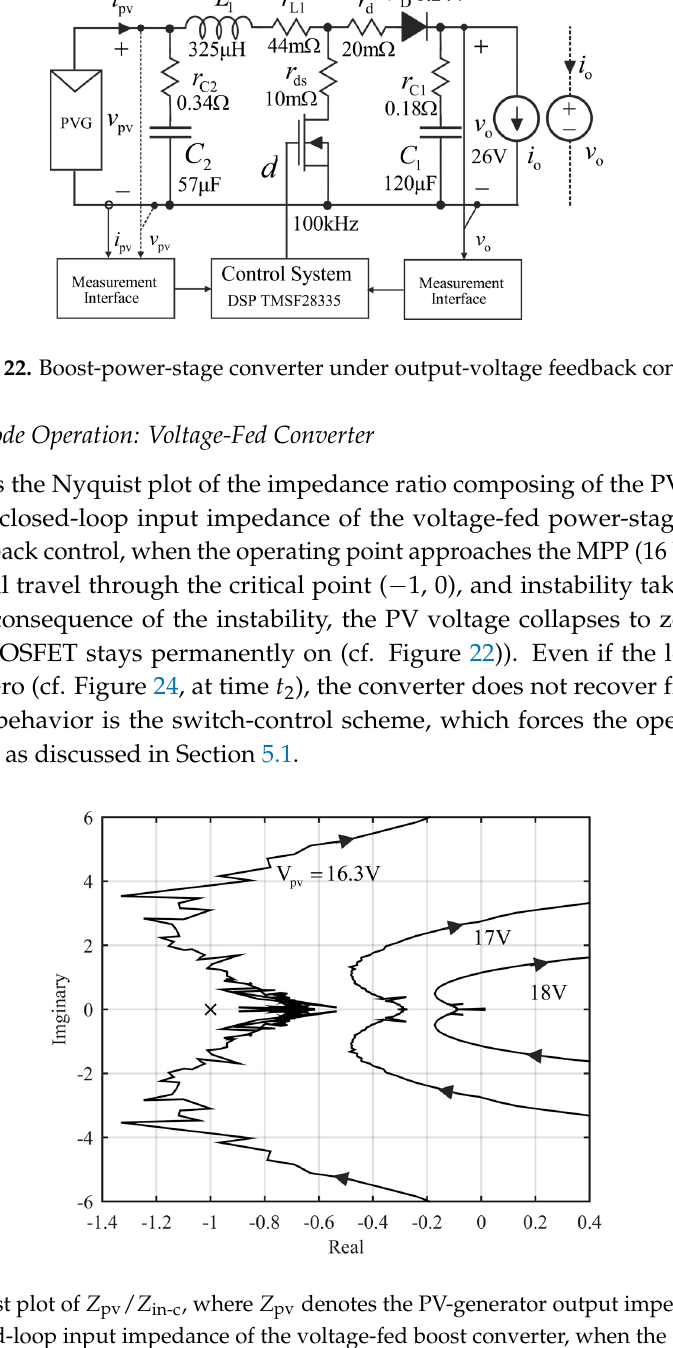
Figure 24. Behavior of boost-converter output voltage ( out v ) and current ( out i ) as well as PV-generator voltage ( pv v ), when the operating point reaches the MPP due to a step change in the output current of the boost converter (i.e., at time 1 t ). It may be obvious that the stable operational region of the output-voltage-feedback-controlled voltage-fed power-stage converter will be always in CVR starting from the open-circuit condition to the highest MPP voltage. In the case of multiple MPPs (cf. Figure 9), the highest-voltage MPP may not be the operating point, at which the highest power lies at all. This may complicate the situation further from the stability point of view. Moving the operating point to the absolute maximum power point or global MPP may not be possible without energy-storage assisted measures. The tracking of the maximum available power in the PV generator is not possible either due to the possibility of instability. The similar behavior will take place also in the PCM-controlled boost converter as reported in [46] due to the negative incremental input resistance of the converter [42]. 5.3. Grid-Forming-Mode Operation: Current-Fed Converter Figure 25 shows the Nyquist plot of the impedance ratio composing of the closed-loop input impedance of the current-fed power-stage converter under output-voltage-feedback control and the